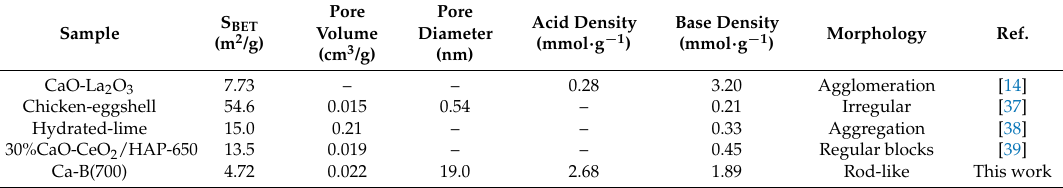
Figure 2. ( A ) SEM image, ( B ) TEM image, ( C ) Elemental mapping, and ( D ) HR-TEM image of Ca-B(700). Table 2. Comparison of structural characteristics of different catalysts.